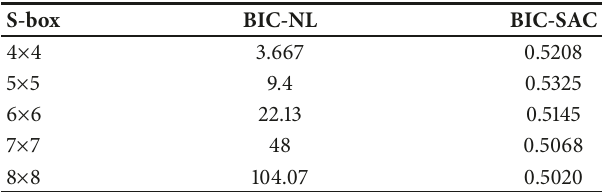
Table 14: BIC scores for the proposed bijective n × n